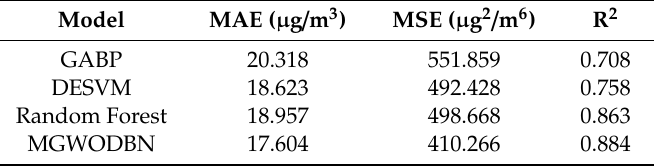
Table 3. Prediction errors of PM2.5 concentration using different models